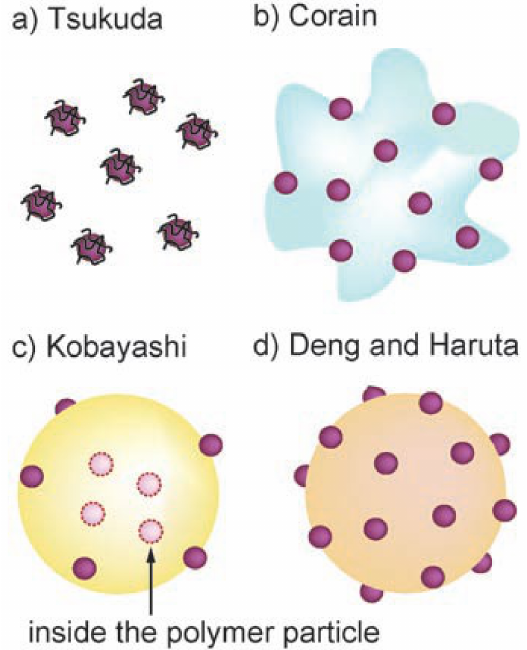
Figure 2. Examples of polymer supported AuNPs for application in catalysis. AuNPs stabilized by water-soluble polymers ( a ), embedded in pores of functionalized resins ( b ), incarcerated in cross-linked polymer ( c ), and supported on polymer surface ( d ). Reproduced with permission from reference